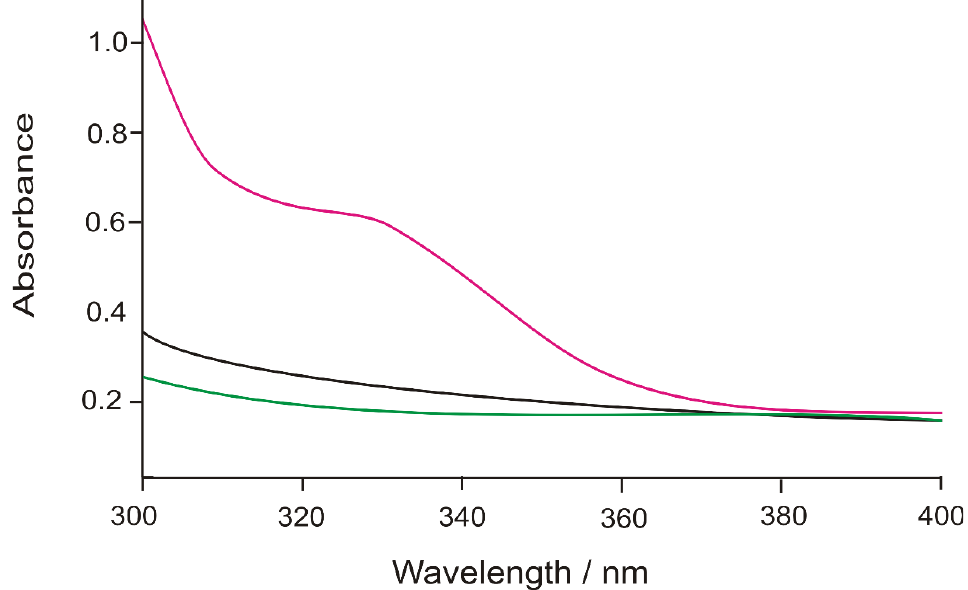
Figure 1. Spectrum of the gallic acid sample with 3% hydrogen peroxide in PBS pH 7 and 5 μ L of horseradish extract (red line); spectrum of the 3% hydrogen peroxide in PBS pH 7 and 5 μ L of horseradish extract (black line); and spectrum of 5 μ L of horseradish extract in PBS pH 7 (green line).